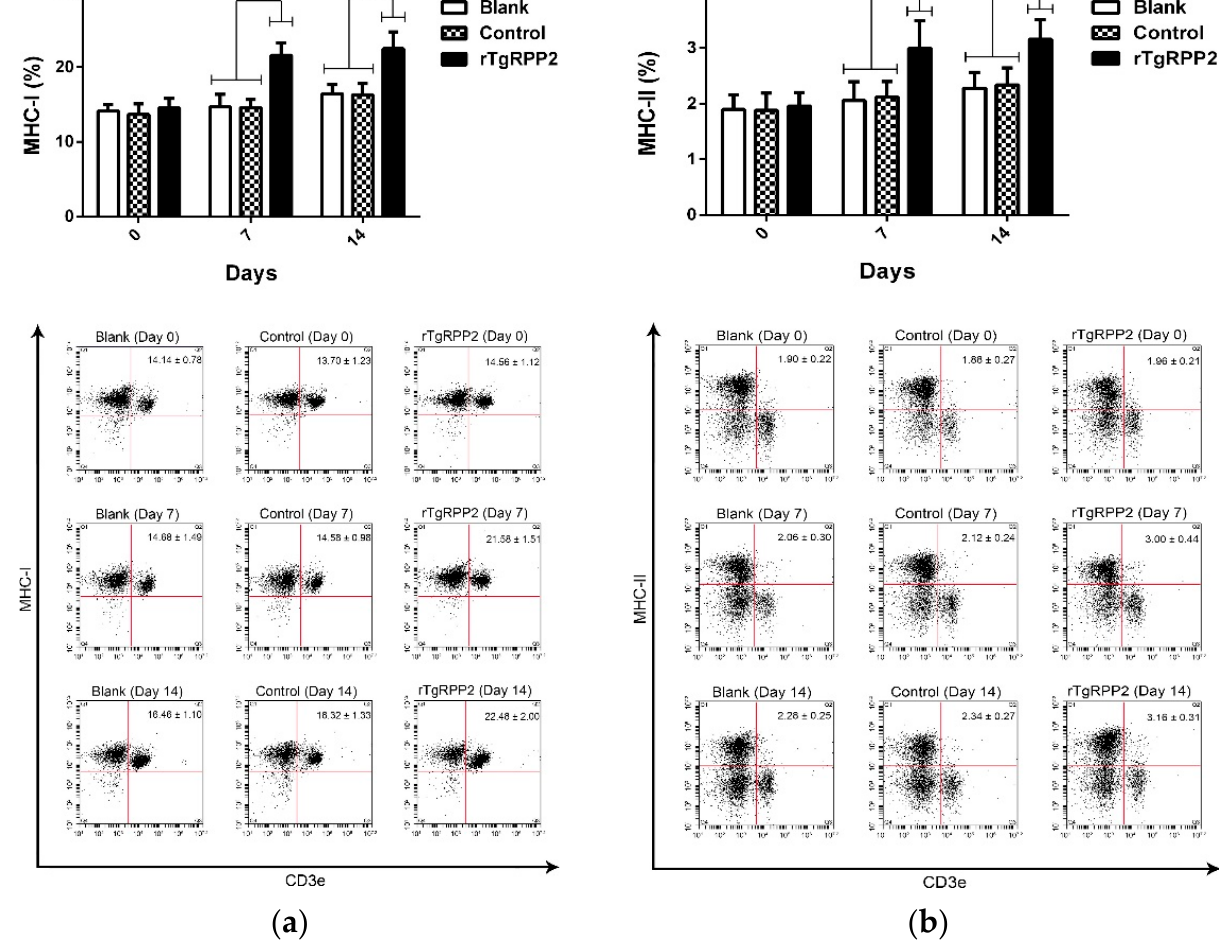
Figure 10. Flow cytometry analysis of major histocompatibility complex (MHC) class I ( a ) and MHC class II ( b ) molecules in murine spleen lymphocytes. Results were evaluated using one-way ANOVA analysis, followed by Dunnett’s test, and values are shown as the mean ± standard deviation ( n = 5). ** p < 0.01 and *** p < 0.001 compared with the blank group or the control group.